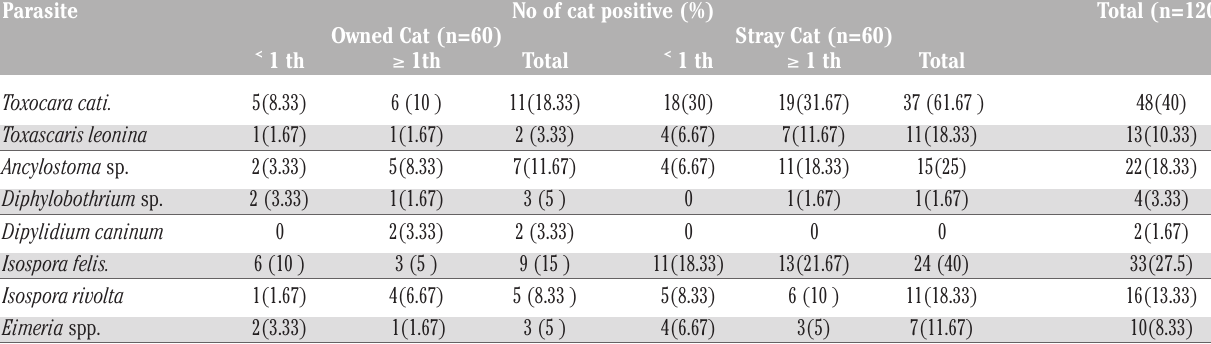
Table 2. The prevalence of each species of gastrointestinal parasites in faecal examined